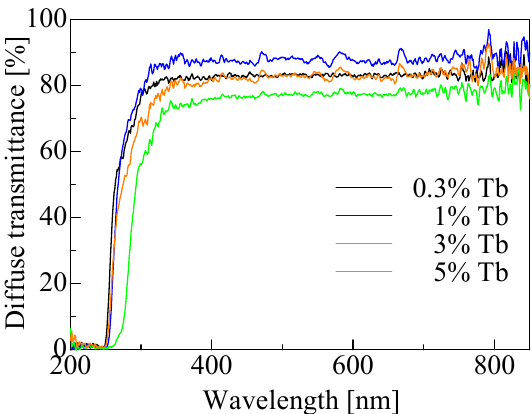
Figure 3. Diffuse transmittance spectra of Tb-doped MgGa 2 O 4 .